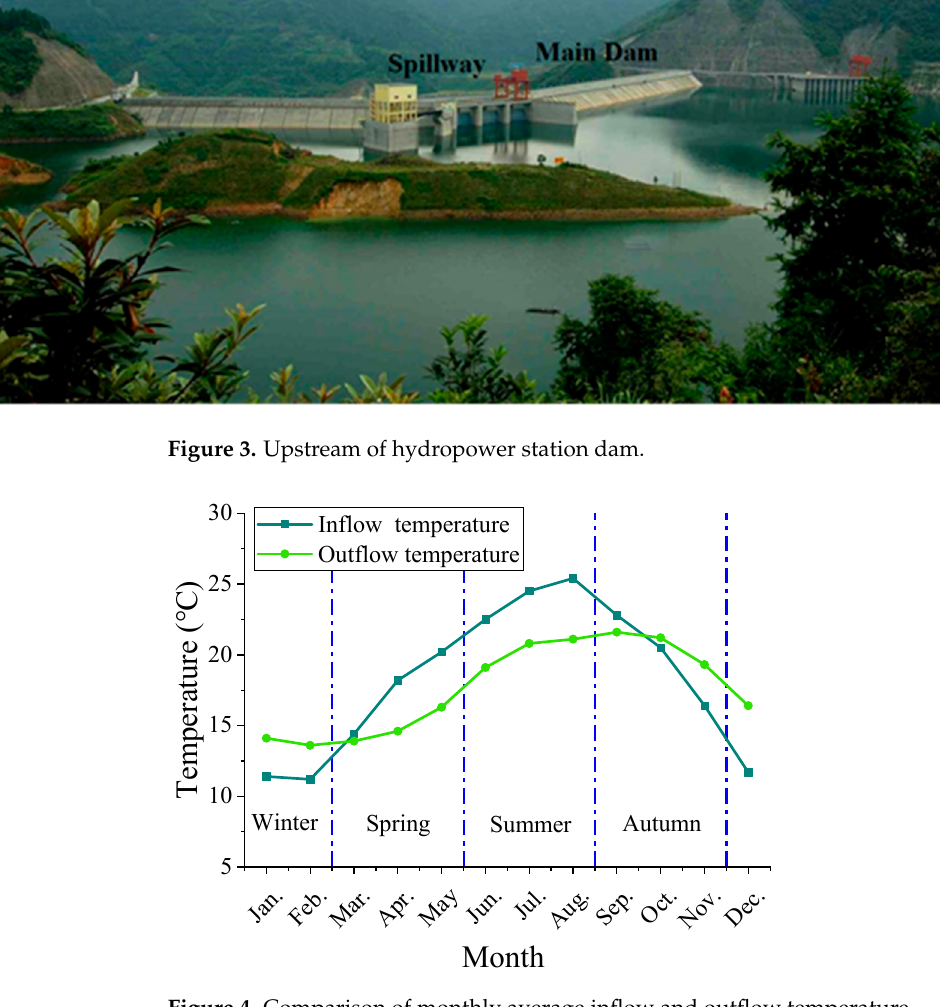
Figure 4. Comparison of monthly average inflow and outflow temperature.